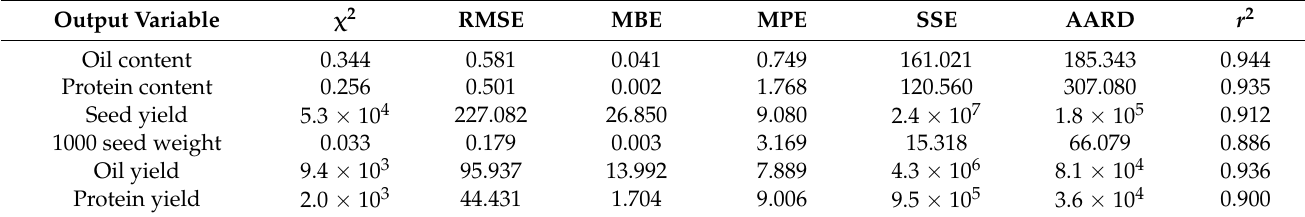
Table 5. The goodness of fit tests for the developed RFR